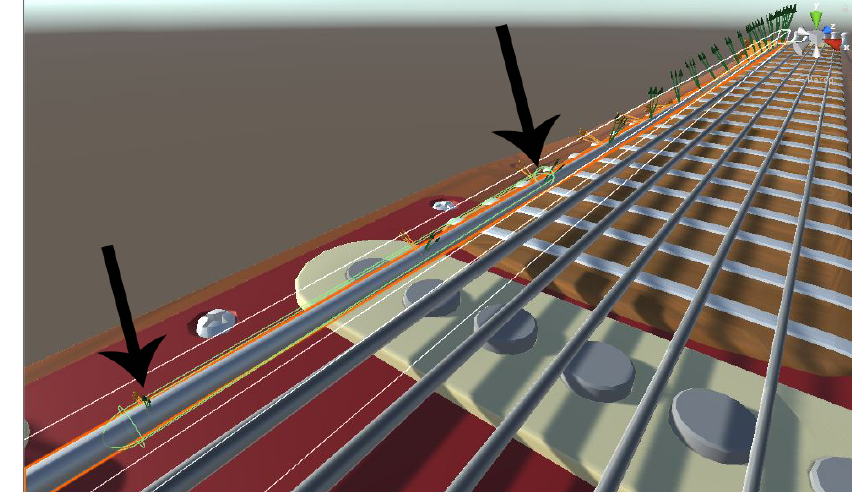
Figure 5. Snapshot of the visual feedback in Keytar using Ultimate Rope Editor. The active region of the collision can be seen bounded by green circles surrounding the first string, each pointed by a black arrow. Small green and red arrows depict the horizontal and vertical components of tangential force vectors exerted by the active string